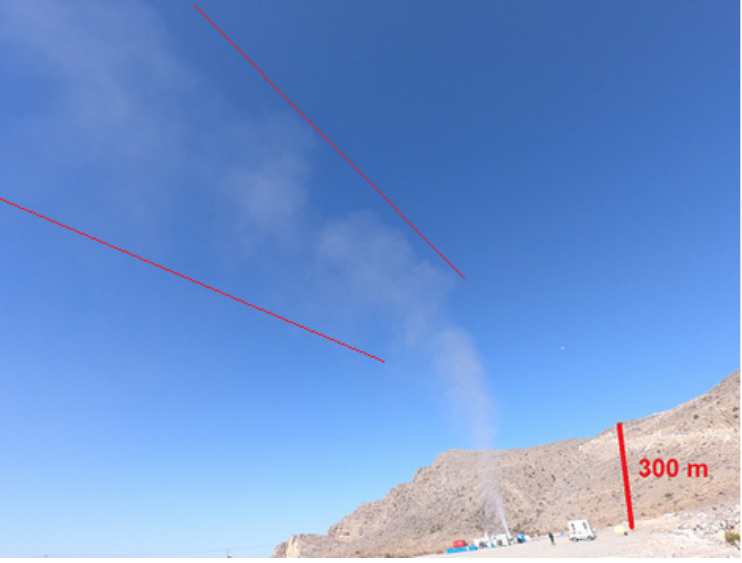
Figure 5. A jet in the clear sky on 24 March 2021.